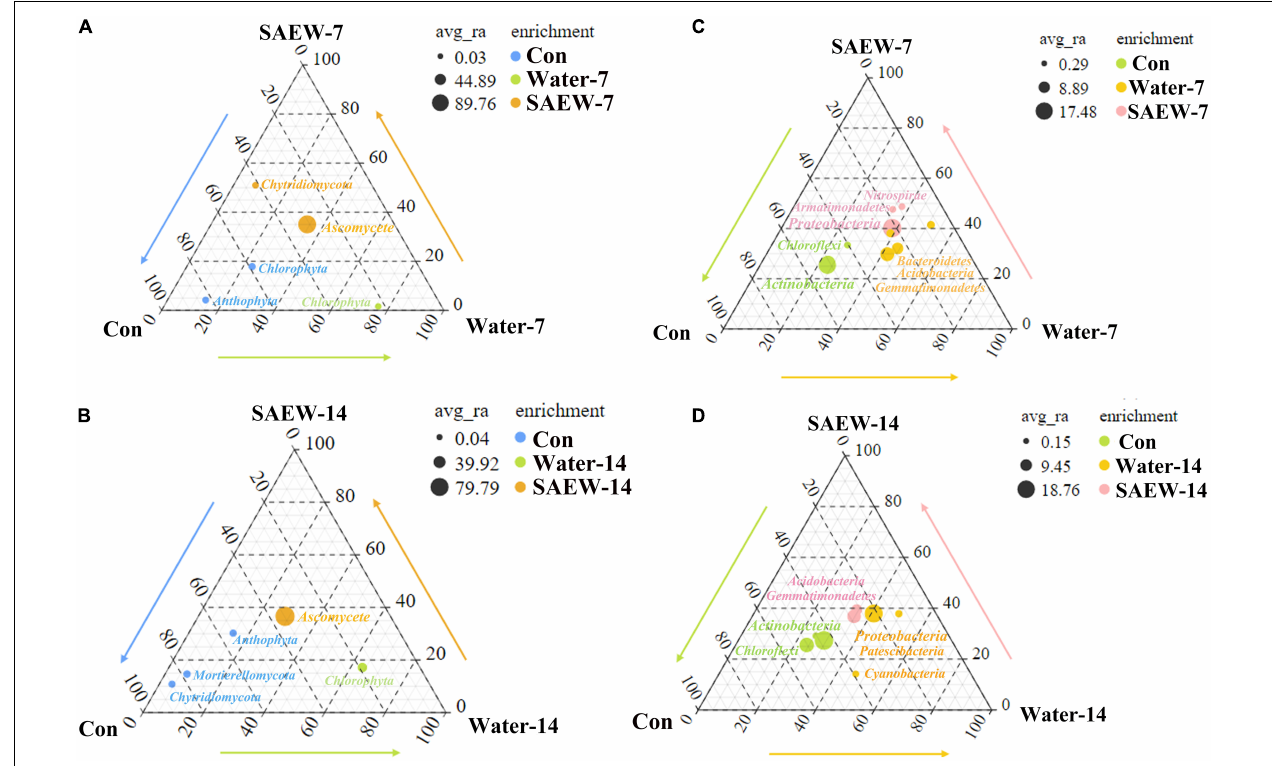
FIGURE 2 | Ternary plot analysis of the indicator species of different treatments of fungus (A,B) and bacteria (C,D) . The top key species (OTUs) in each treatment were labeled in the corresponding color. The soils with different treatments (Con, Water-7, Water-14, SAEW-7, and SAEW-14) were separately collected from 5 replicated pots for each. Con and control (dry soil); Water-7 (the soil irrigated with deionized water for 7 days); Water-14 (the soil irrigated with deionized water for 14 days); SAEW-7 (the soil irrigated with 60 ppm concentration of slightly acidic electrolyzed water for 7 days); SAEW-14 (the soil irrigated with 60 ppm concentration of slightly acidic electrolyzed water for 14